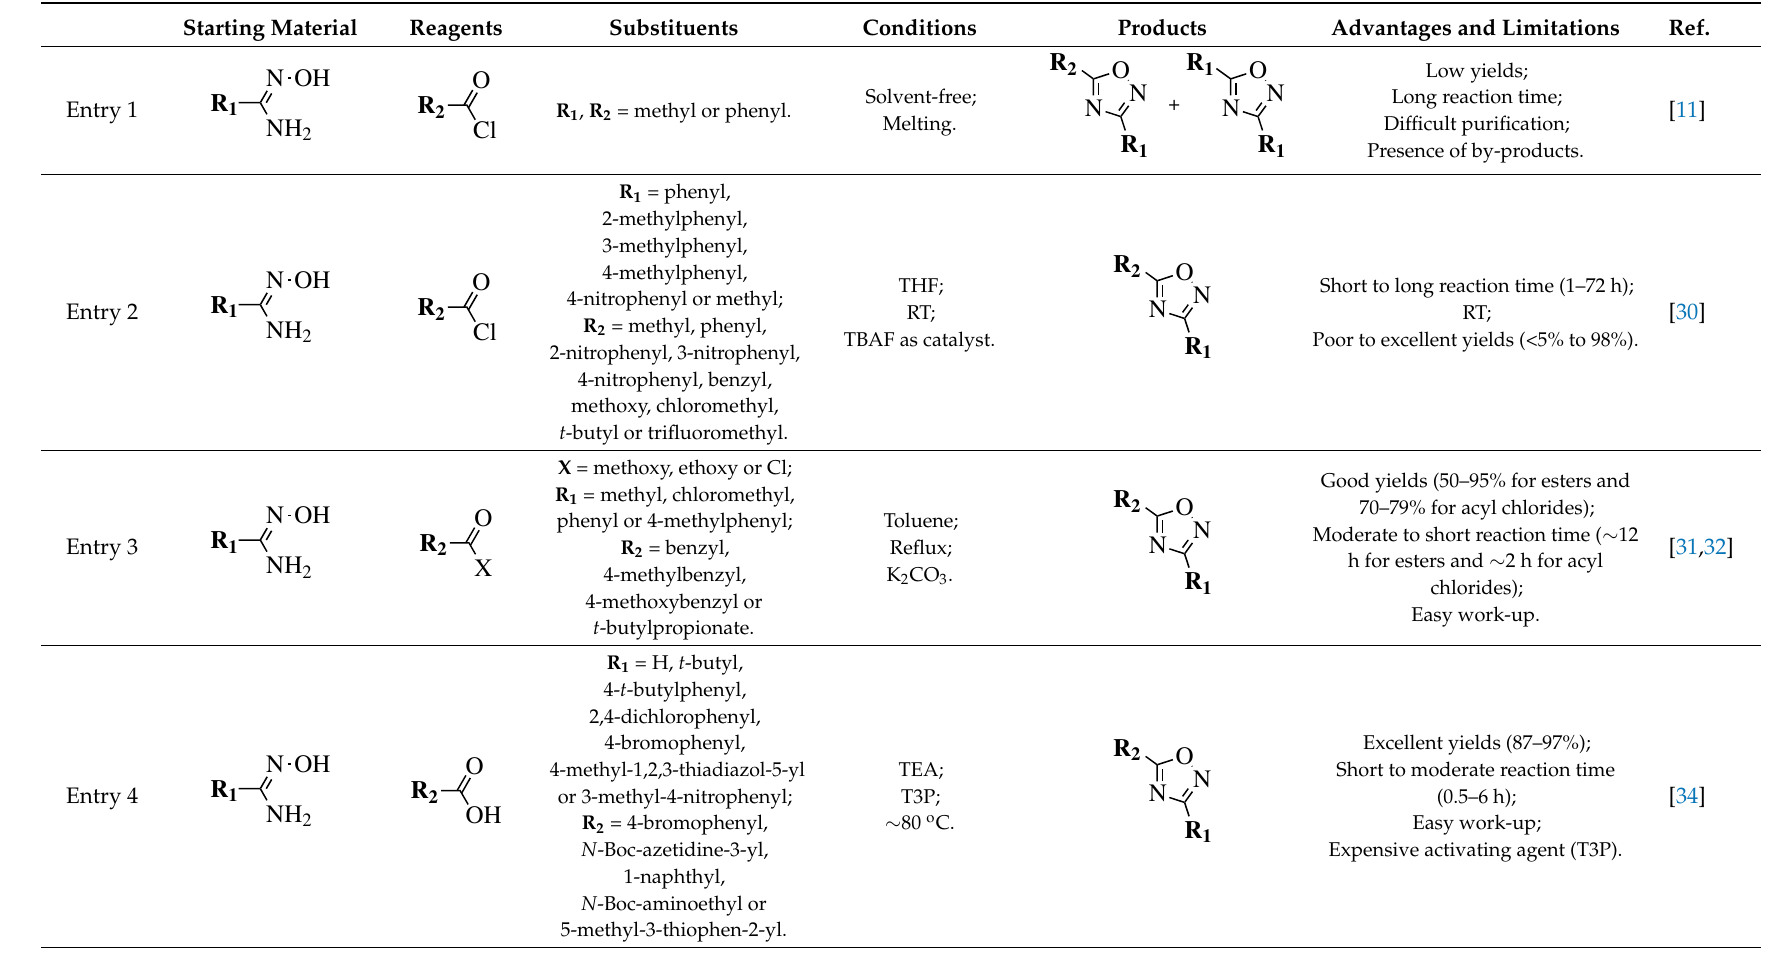
Table 1. Methods of synthesis of 1,2,4-oxadiazole